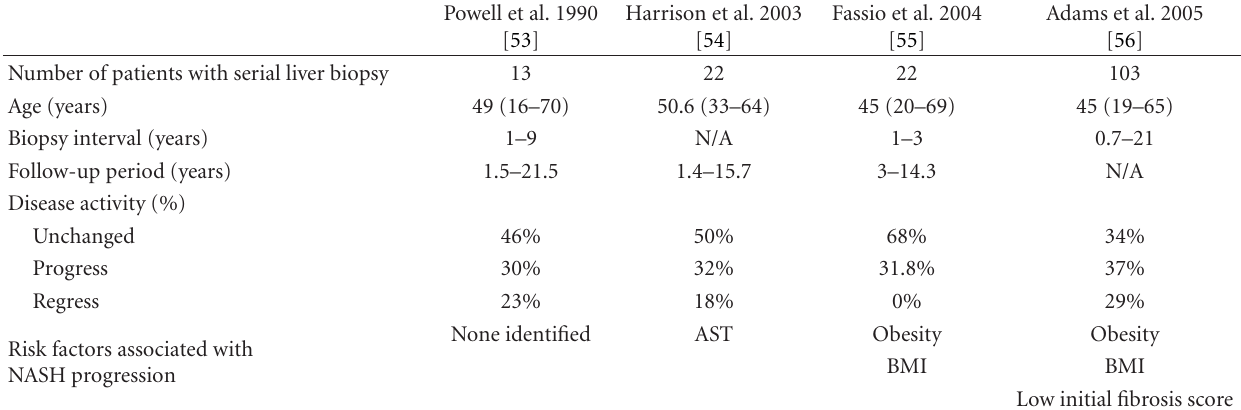
Table 1: Disease progression in NAFLD/NASH and risk factors predicting disease progression